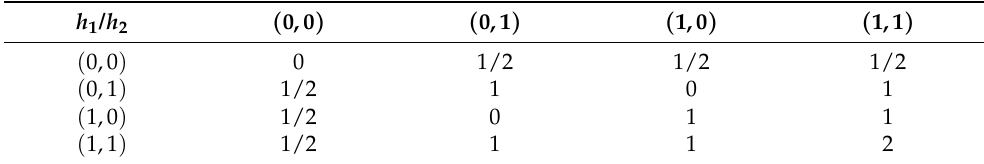
Table 1. The possible genomic configurations with two sites; ( a , b ) for a , b ∈ { 0,1 } denotes a haplotype with type a at site one and type b at site two; the entries are example values of the weight function in Equation